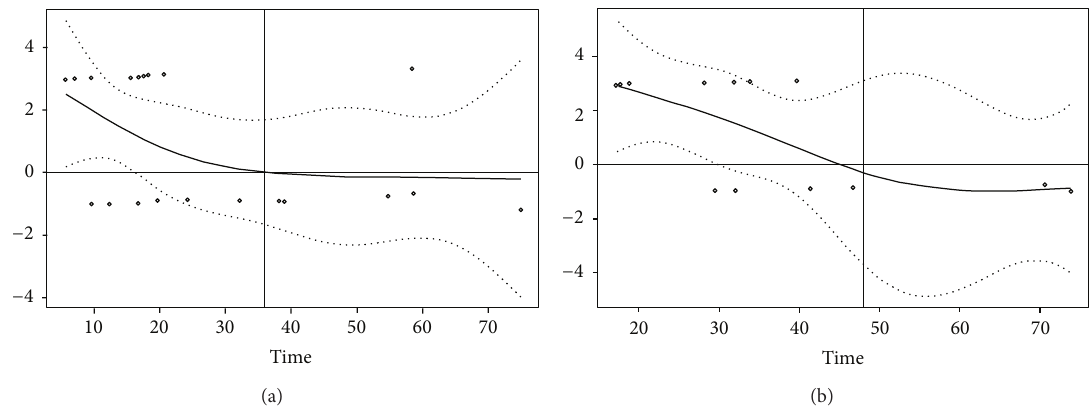
Figure 3: Hazard ratio estimates over time. The plain line shows the hazard ratio estimate (logarithmic scale) over time (in months) for DMFS (a) and OS (b), together with the 95% confidence interval (hashed lines). The vertical line is set at 36 months for DMFS and 48 months for OS. Circles show Schoenfeld’s